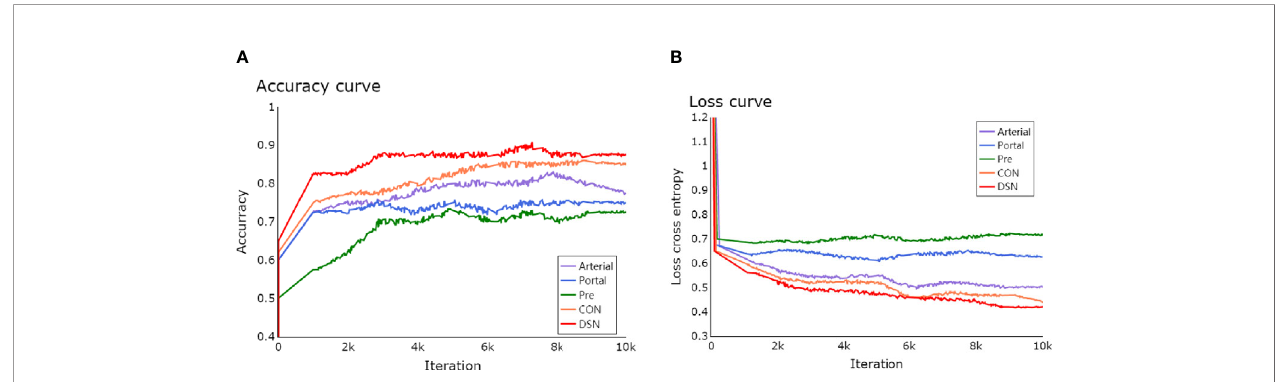
FIGURE 4 | Test loss and accuracy (A) curves for different iterations (B)